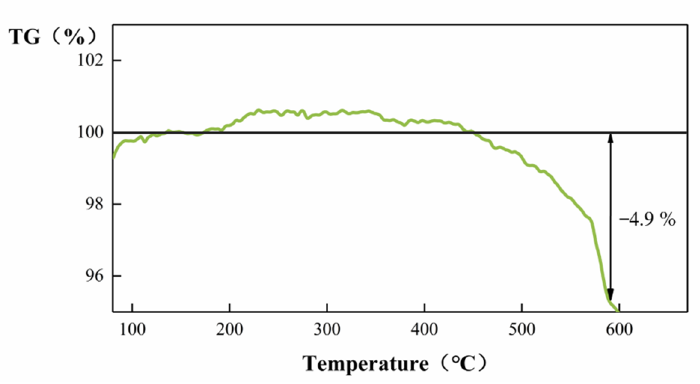
Figure 11. TG curve of the ZnO@ZIF-8 composite.